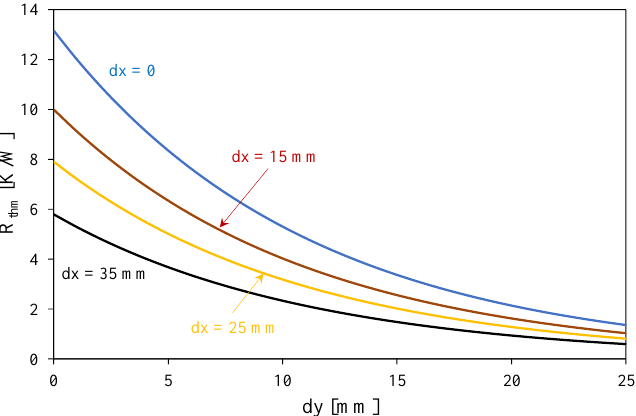
12 of 20 Figure 9. Dependence of inductance ( a ) and series resistance ( b ) of the transmitting and receiving coils on the frequency of the exciting signal. As can be seen, both the inductance and series resistance of both windings are signif- icantly different from each other. In the frequency range f < 5 MHz, the inductance values of the transmitter and the receiver are practically constant. The observed differences be- tween the inductances of the transmitter and the receiver result from the different number of turns contained in these windings. At the highest frequency value under consideration,